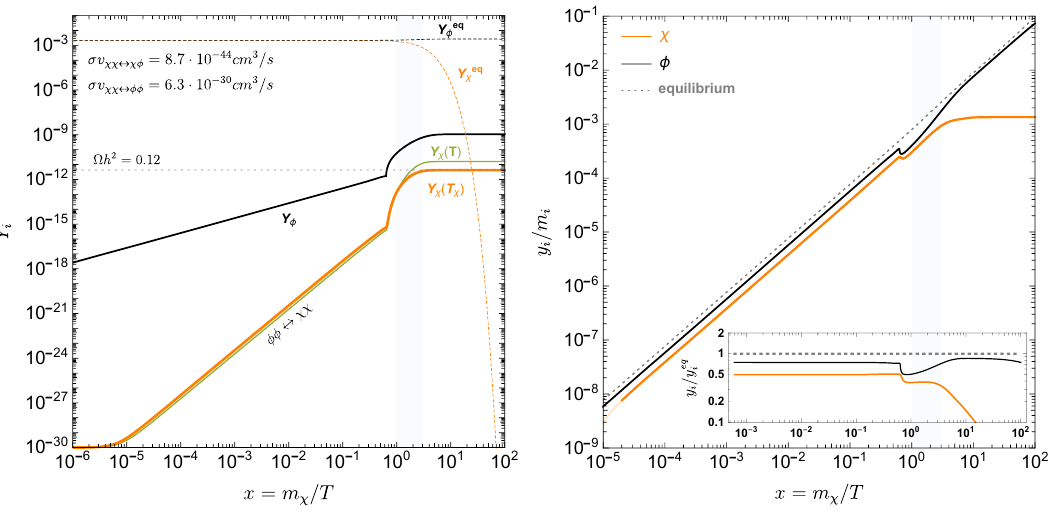
Figure 3 . The same as in figure 2, but for m χ = 100 GeV, µ φ = 1 GeV, λ 1 = 10 − 10 , λ 2 = 10 − 3 , λ hφ = 2 × 10 − 11 and θ = 10 − 5 , which makes pair-production the dominant